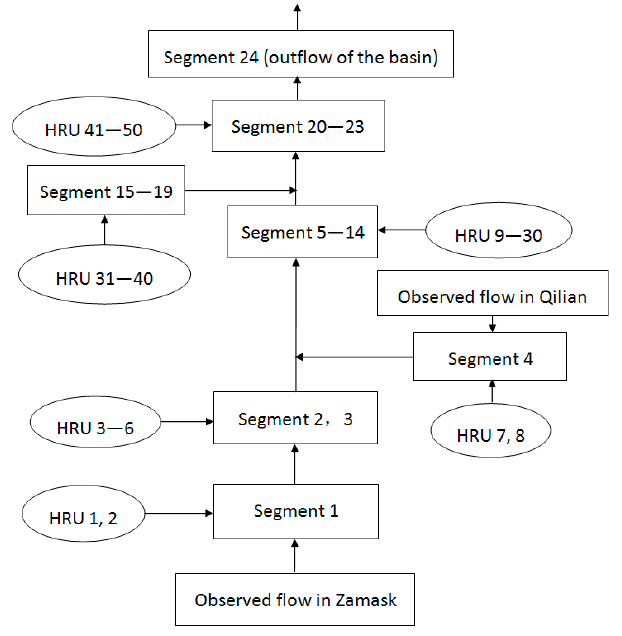
Figure 5. Hydrological model structure for the Zamask-Yingluoxia Basin.